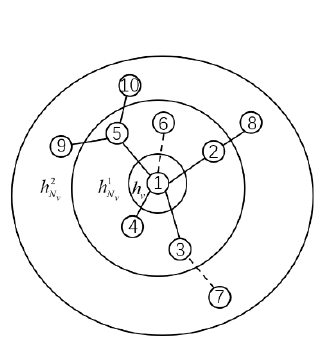
Figure 3. Neighborhood